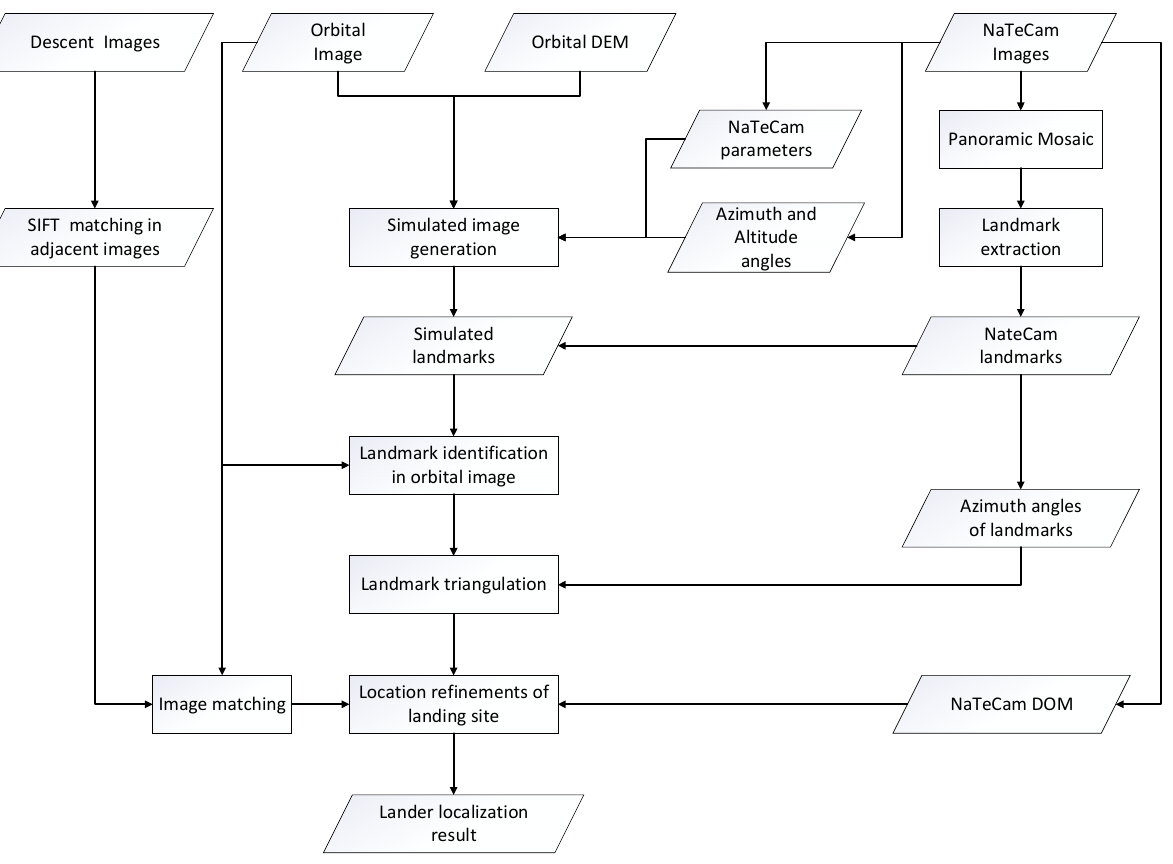
Figure 2. The workflow of the proposed